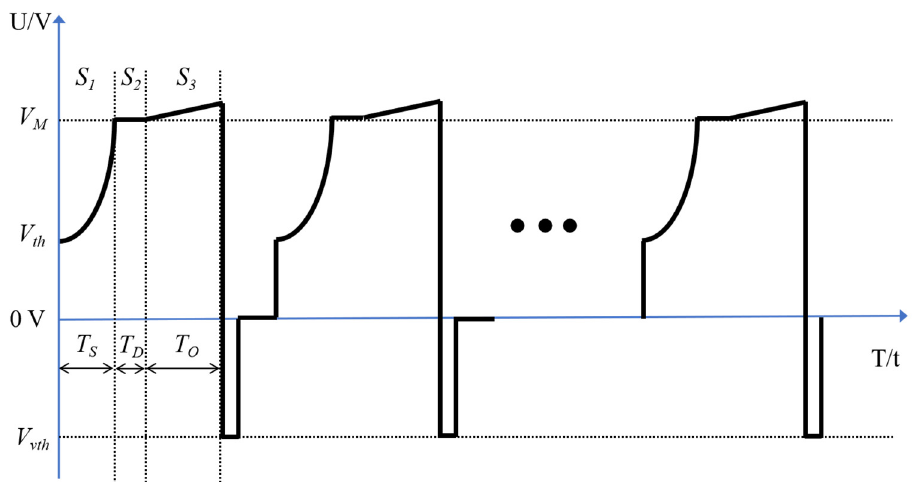
Figure 3. A schematic diagram of the proposed driving waveform for EWDs. S 1 is an oil splitting suppression stage, S 2 is a DC driving stage, and S 3 is an oil stabilization stage. V M is the voltage at which pixels can be driven to a target grayscale. V th is the positive threshold voltage of EWDs. V vth is the negative threshold voltage. T S , T D and T O are durations of the oil splitting suppression stage, the DC driving stage and the oil stabilization stage.